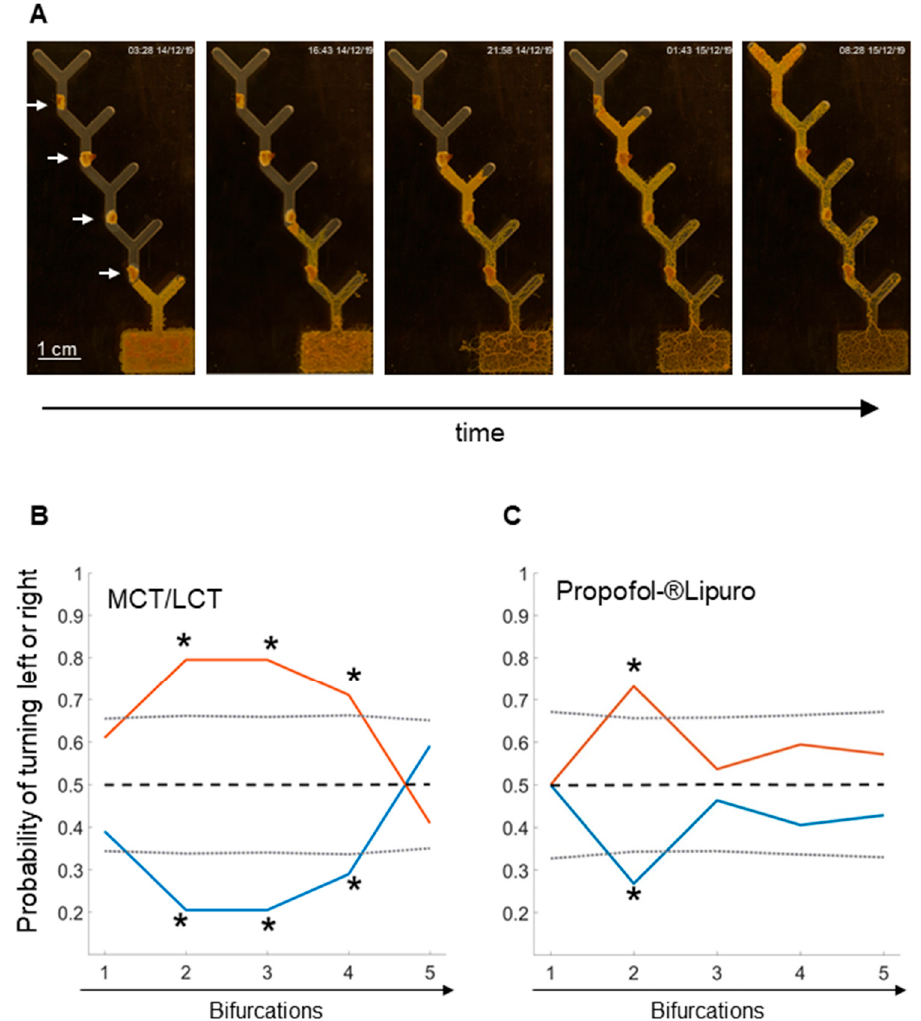
Figure 1. The 5-level Y-maze: ( A ) Exemplary course of an experiment with Physarum in a 5-level Y-maze. Starting with a rectangular chamber, Physarum spreads out along successive bifurcations. At each of the first 4 bifurcations, Physarum ’s favorite food, an oat flake, is placed at the tip of the left arm (see white arrows). The oat flakes are either soaked with MCT/LCT or Propofol- ® Lipuro. The fifth bifurcation is devoid of an oat flake. ( B ) Probability representation of Physarum ´ s direc- tional decisions at each bifurcation in the 5-level Y-maze with oat flakes soaked with MCT/LCT or ( C ) Propofol- ® Lipuro. The red lines represent the decision to the left (oat) and the blue lines to the right (no oat). The dashed black lines indicate the mean, and the grey do tt ed lines indicate the con fi dence intervals of two times the standard deviation. Values greater or less than this limit in- dicate signi fi cance (* = p < 0.05). The graphs represent 50 experiments for each condition (MCT/LCT or Propofol- ® Lipuro).